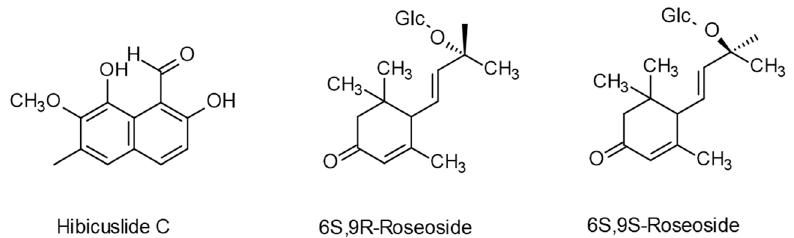
Figure 3. Less known secondary metabolites found in extracts of A. theophrasti: hibiscuslide C and roseosides, identified by Hwang et al. and Mamadalieva et al. [106,107].